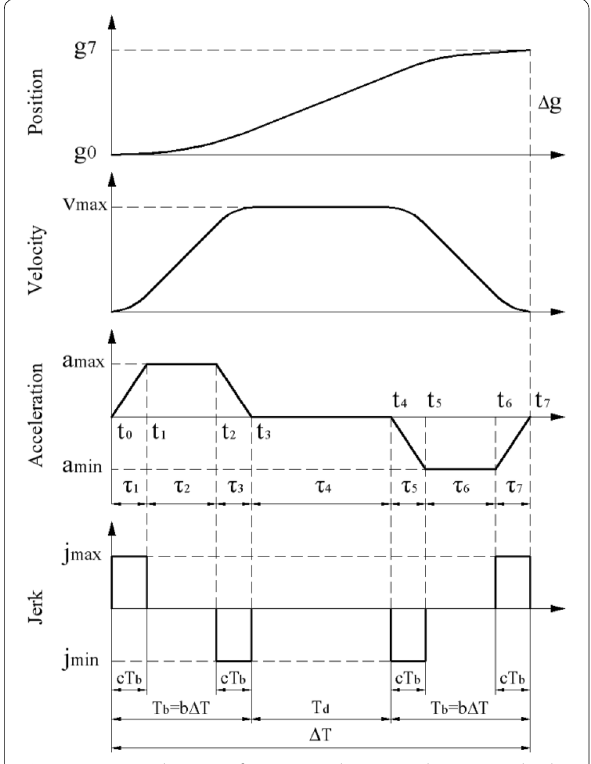
Figure 12 Typical curves of position, velocity, acceleration, and jerk for double-S